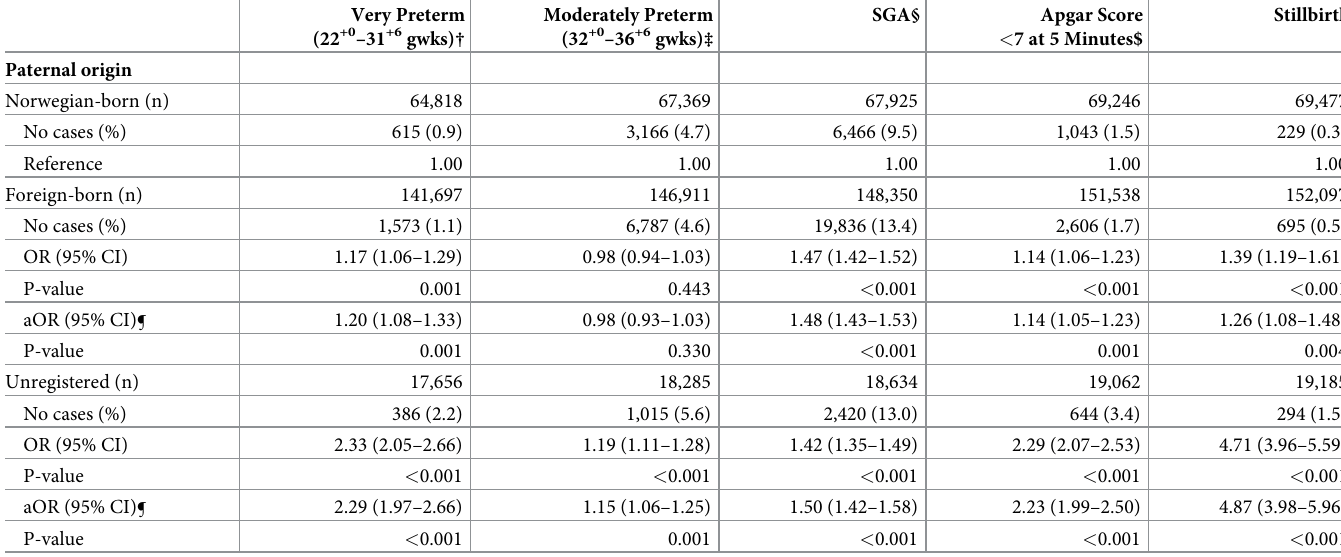
Table 2. Associations between paternal origin and adverse neonatal outcomes in births to migrant women in Norway